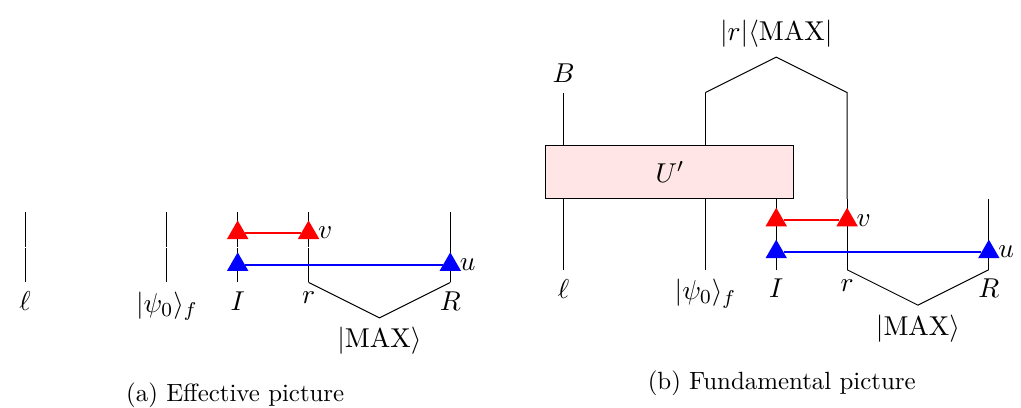
Figure 2. A model with an infaller. The infaller can interact with the exterior (blue gate) or interior (red gate) radiation